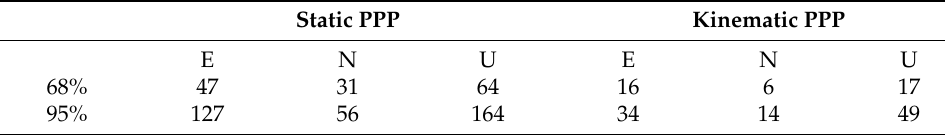
Table 13. Convergence time of the EG method (unit: min) (G/R/E). Static PPP Kinematic PPP